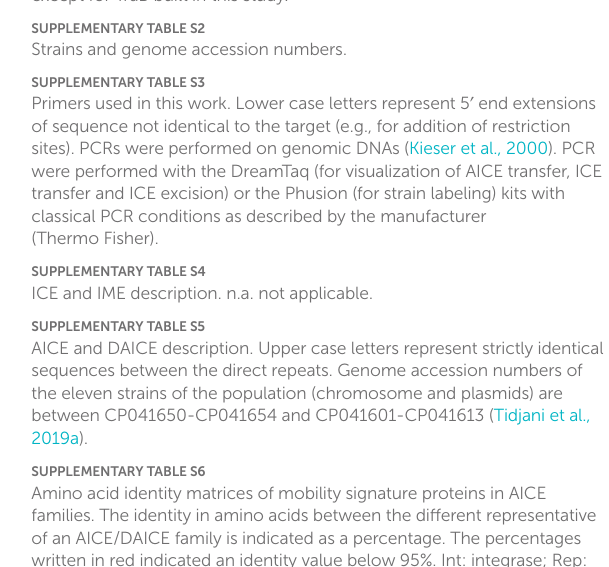
SUPPLEMENTARY TABLE S6 Amino acid identity matrices of mobility signature proteins in AICE